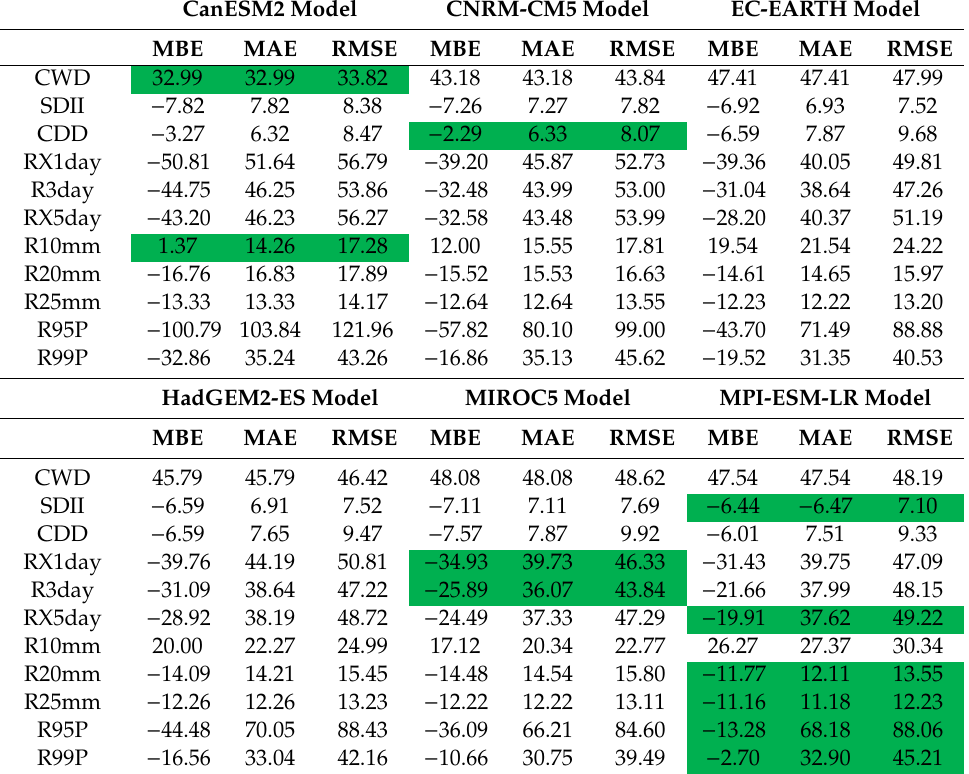
Table 13. Average of the statistical criteria of the indices for all the stations